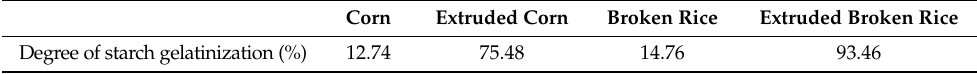
Table 2. Degrees of starch gelatinization in extruded/unextruded corn and broken rice.